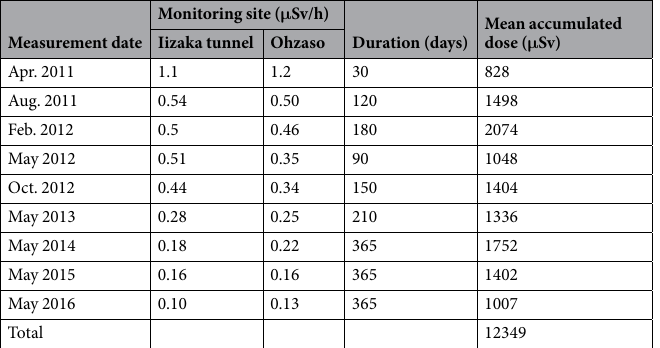
Table 2. Air doses measured at monitoring sites maintained by Fukushima Prefecture near the study area ( μ Sv/h). Mean accumulated doses were estimated to multiply the average value of air doses in two monitoring site by the number of days between consecutive measurement